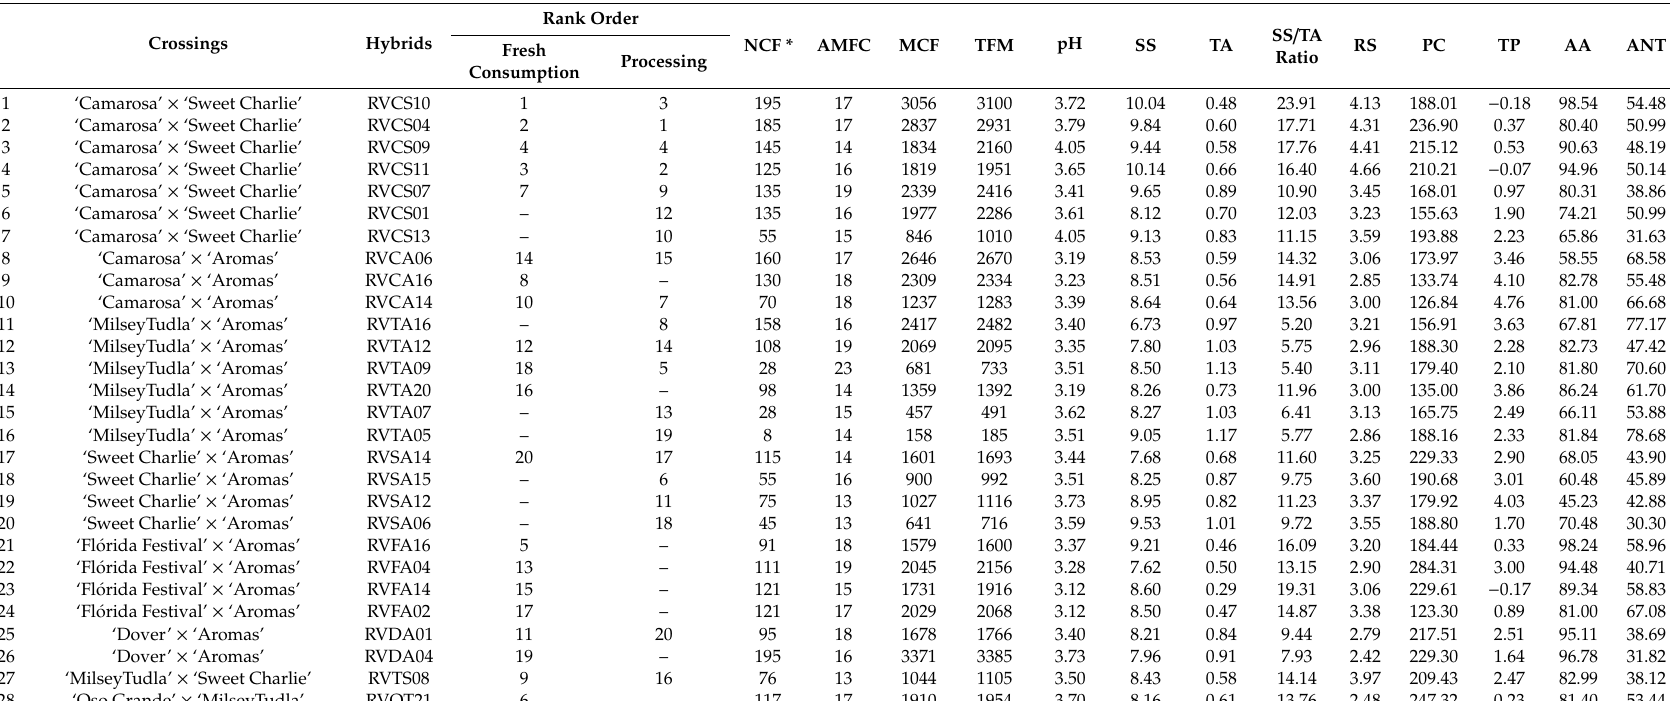
Table 3. Crossings, rank order, and adjusted means for Fragaria × ananassa Duchesne ex Rozier hybrids selected in the first ten positions based on the Mulamba and Mock [27] selection index, with economic weights established for the selection for fruit production for fresh consumption and